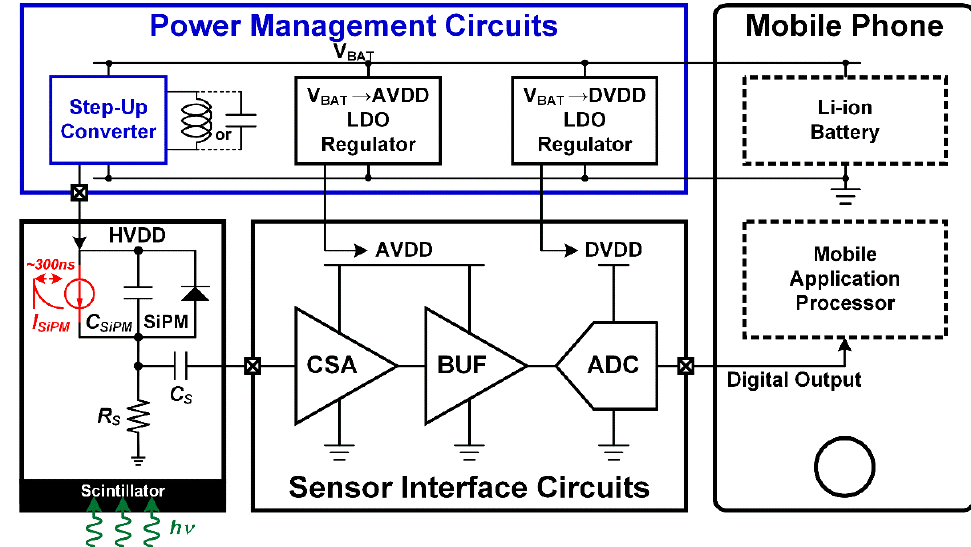
Figure 1. Block diagram of mobile radiation sensor interface.